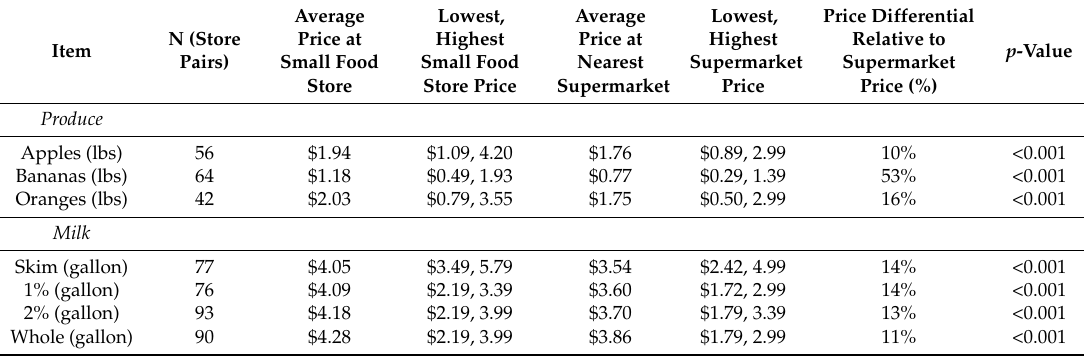
Table 2. Price differences between small food stores and nearest supermarkets with item available for 15 products in Minneapolis and St. Paul, MN,